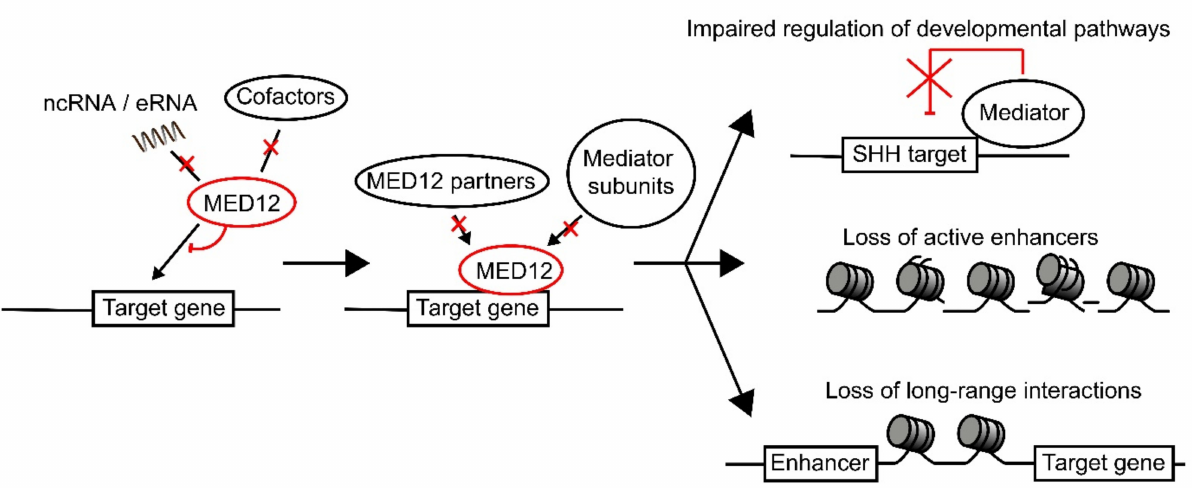
Figure 4. Model for the pathogenic effect of MED12 variants. MED12 recruitment to its target gene is regulated via interaction with ncRNAs, eRNAs, and cofactors such as REST. We propose that specific mutations in MED12 disrupt its interactions with either ncRNAs, eRNAs, or cofactors, depending on where the mutation is present in the protein. This leads to reduced recruitment of MED12 to the target genes, which will in turn result in lower MED12-mediated recruitment of additional factors, such as G9a, as well as other Mediator subunits. This will lead to loss of regulation over developmental pathways, loss of regulation over chromatin state (leading to loss of active enhancers), as well as loss of long-range transcriptional